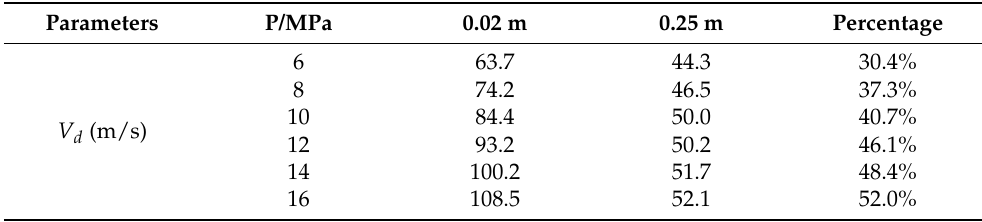
Table 6. Variation rate of droplet velocity.